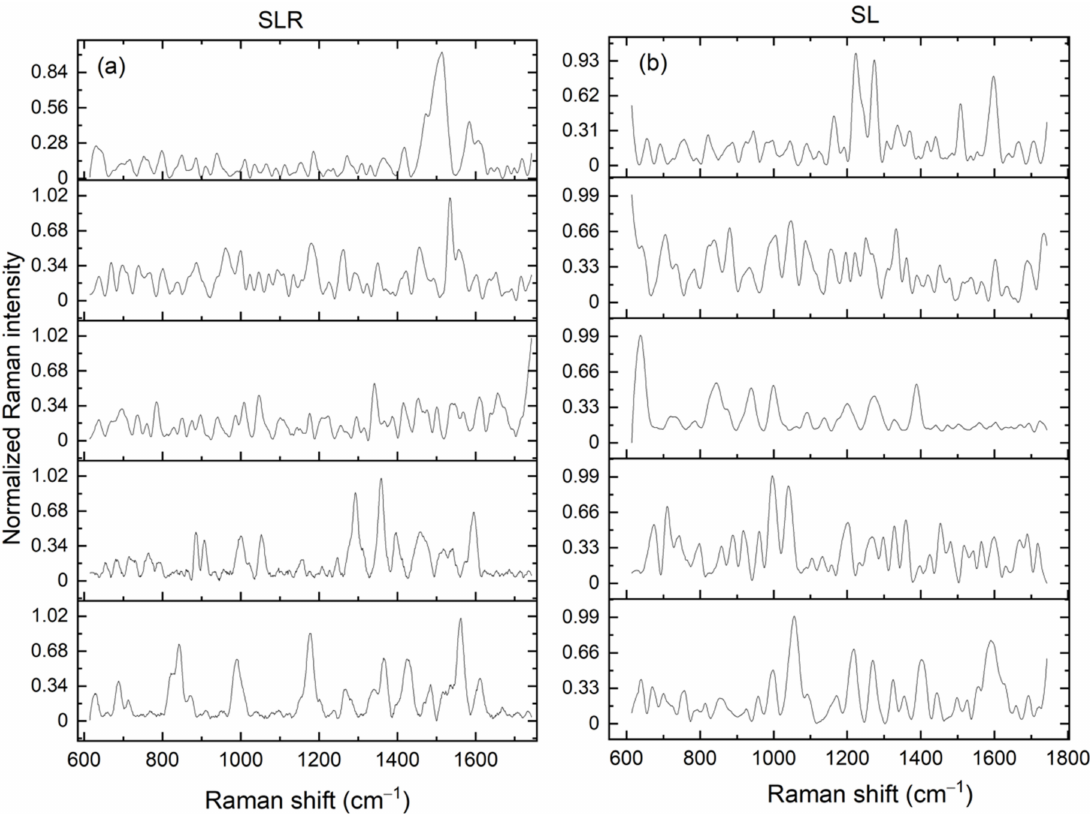
Figure 8. SERS spectra of different positions for ( a ) SLR and ( b ) SL performed on different positions after smoothing, subtraction, and normalization. Acquisition time 3 s, wavelength 632.8 nm, power 50 microwatt. SERS spectra are recorded on the same substrate; each spectrum is the result of an average of three spectra taken from three positions. The raw data are presented in the Supplementary Materials (see Figure